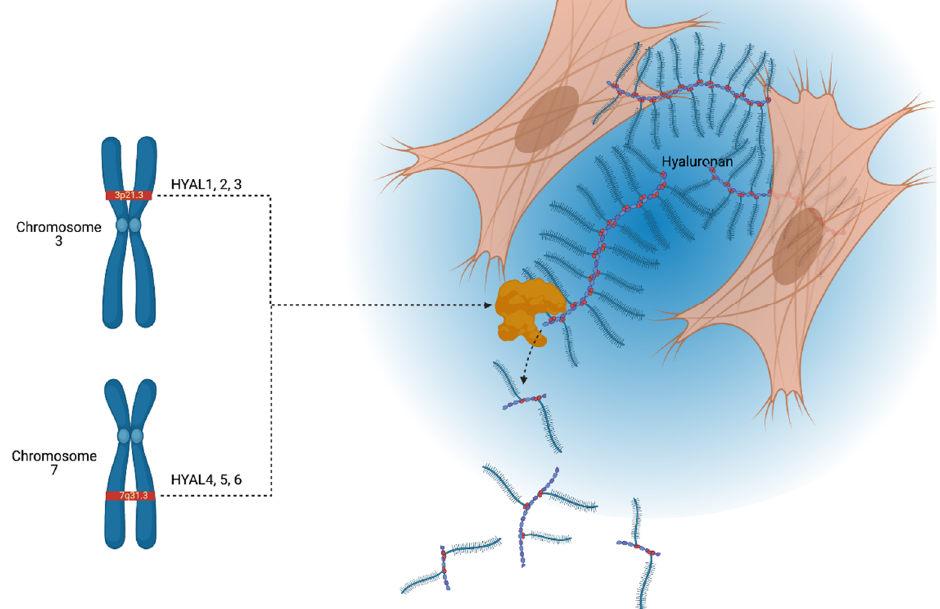
Figure 1. Schematic illustration depicting the chromosomal locations of hyaluronidases ( HYALs ) 1–6 and a secreted HYAL enzyme cleaving hyaluronic acid (HA). HYALs 1–3 are located on chromosome loci 3p21.3, and HYALs 4–6 on 7q31.3. Hyaluronidases are involved in the constant turnover of the extracellular proteoglycan hyaluronan, generating fragments of various molecular weights depending on the type of hyaluronidase. Pictured here is an extracellular hyaluronidase degrading HA, although it is important to note that HYAL may reside inside endosomes or be bound to the membrane surface. This figure is a broad illustration and is not drawn to scale. Created with BioRender.com.